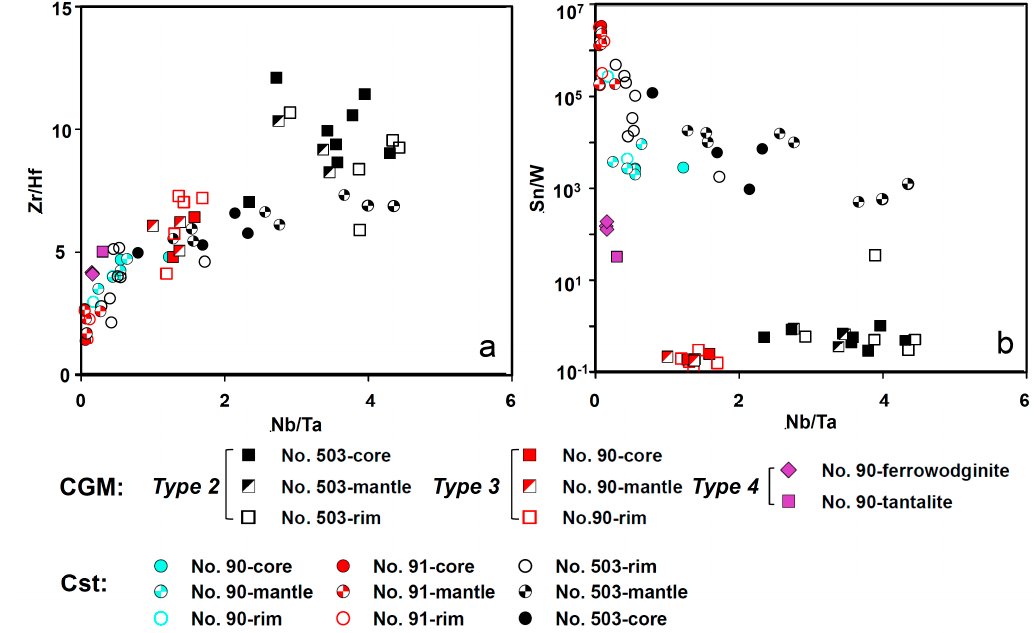
Figure 12. ( a ) Zr/Hf versus Nb/Ta plots and ( b ) Sn/W versus Nb/Ta for Nb-Ta oxides and cassiterite, respectively. Ratios are calculated base the results of LA-ICP-MS analyses of both CGM and cassiterite. See text for detailed explanation on the variations in Nb/Ta, Zr/Hf, and Sn/W ratios of CGM and cassiterite.